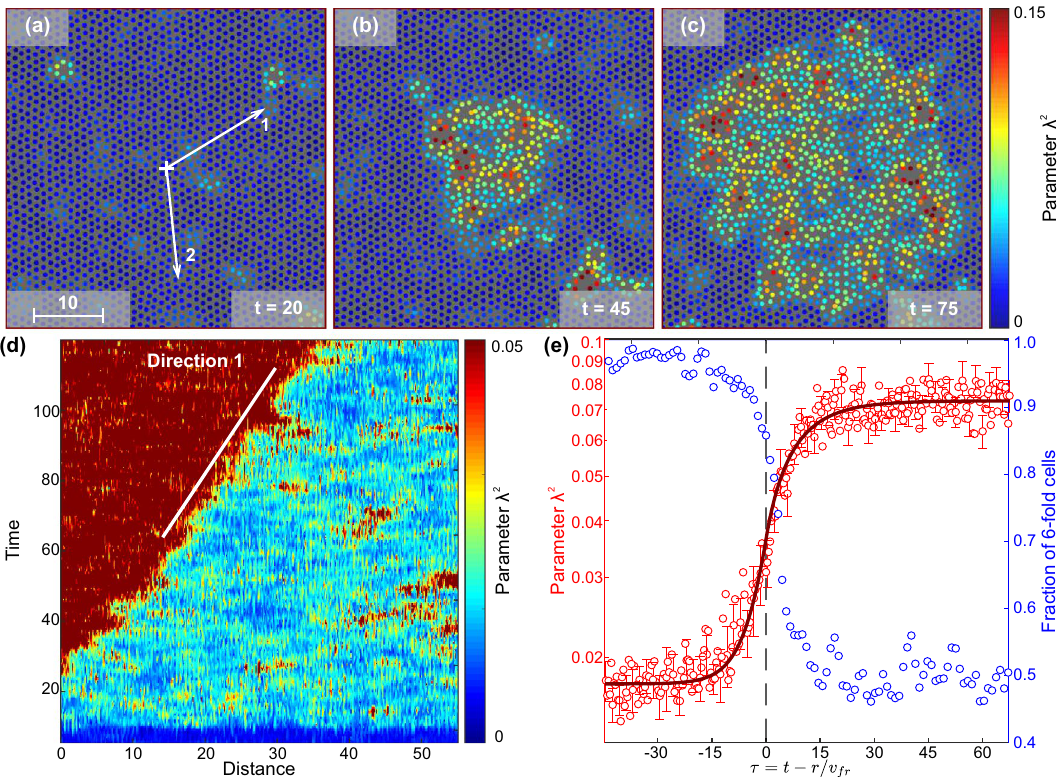
Figure 3. The self-similar (cid:31) 2 -profile of the propagating melting front in superheated bulk crystal observed with MD simulation: the description is the same as in Fig. 2. See also Supplemental Movie